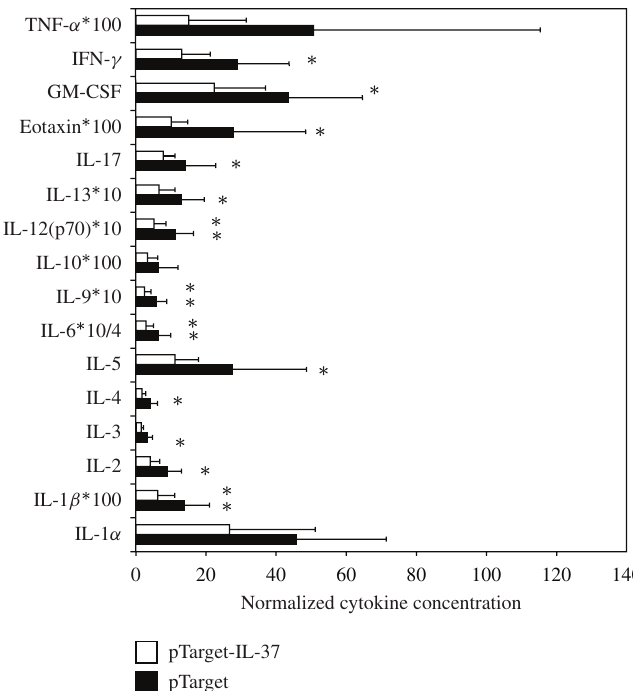
FIGURE 3: LPS-induced serum cytokines in mice expressing IL-37. Tail vein injected C57/Bl6 mice (with or without IL-1F7b plasmid-DNA) were challenged with LPS (10 μ g) intraperintoneally ( n = 7–9). After 2 hrs the mice were sacrificed and serum cytokines were measured by a multiarray cytokine assay as